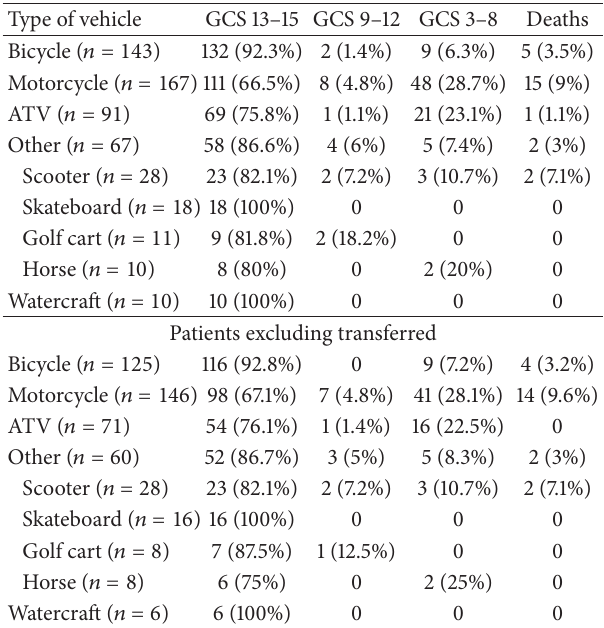
Table 3: Types of vehicles and presenting